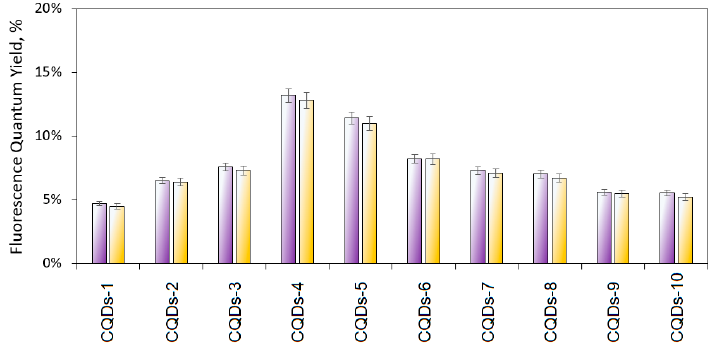
Figure 5. Fluorescence quantum yield of prepared CQDs. Violet bars—freshly after synthesis and purification. Yellow bars—fluorescence quantum yield after 2 months (photostability).